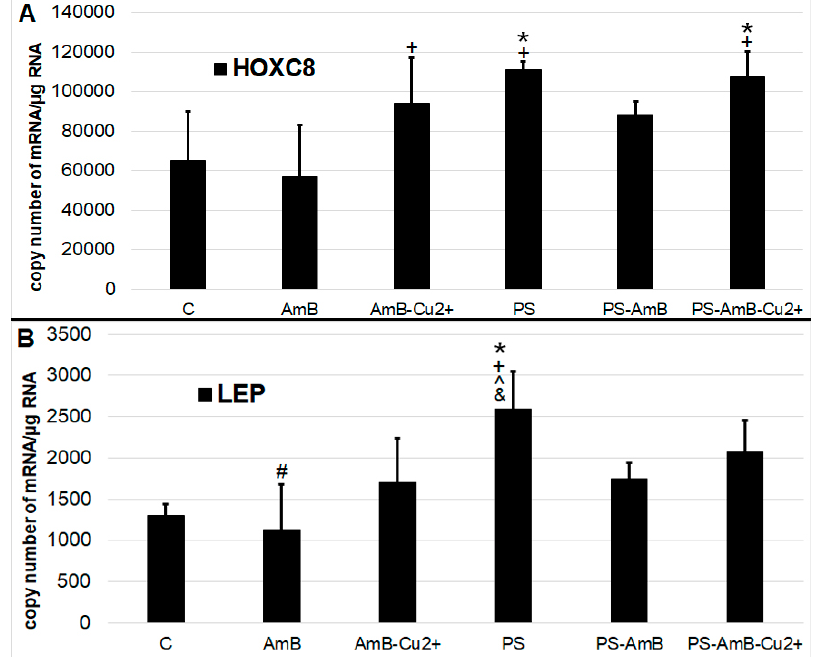
Figure 6. The mRNA levels of adipose tissue markers (( A )— HOXC5 ; ( B )— LEP ). The bars represent the means ± standard deviation (SD) of the copy numbers per 1 µg of total RNA; ANOVA with the Tukey post hoc test, * p < 0.05 vs. control, # p < 0.05 vs. PS, ^ p < 0.05 vs. AmB-Cu 2+ , + p < 0.05 vs. AmB, & p < 0.05 vs. PS-AmB.